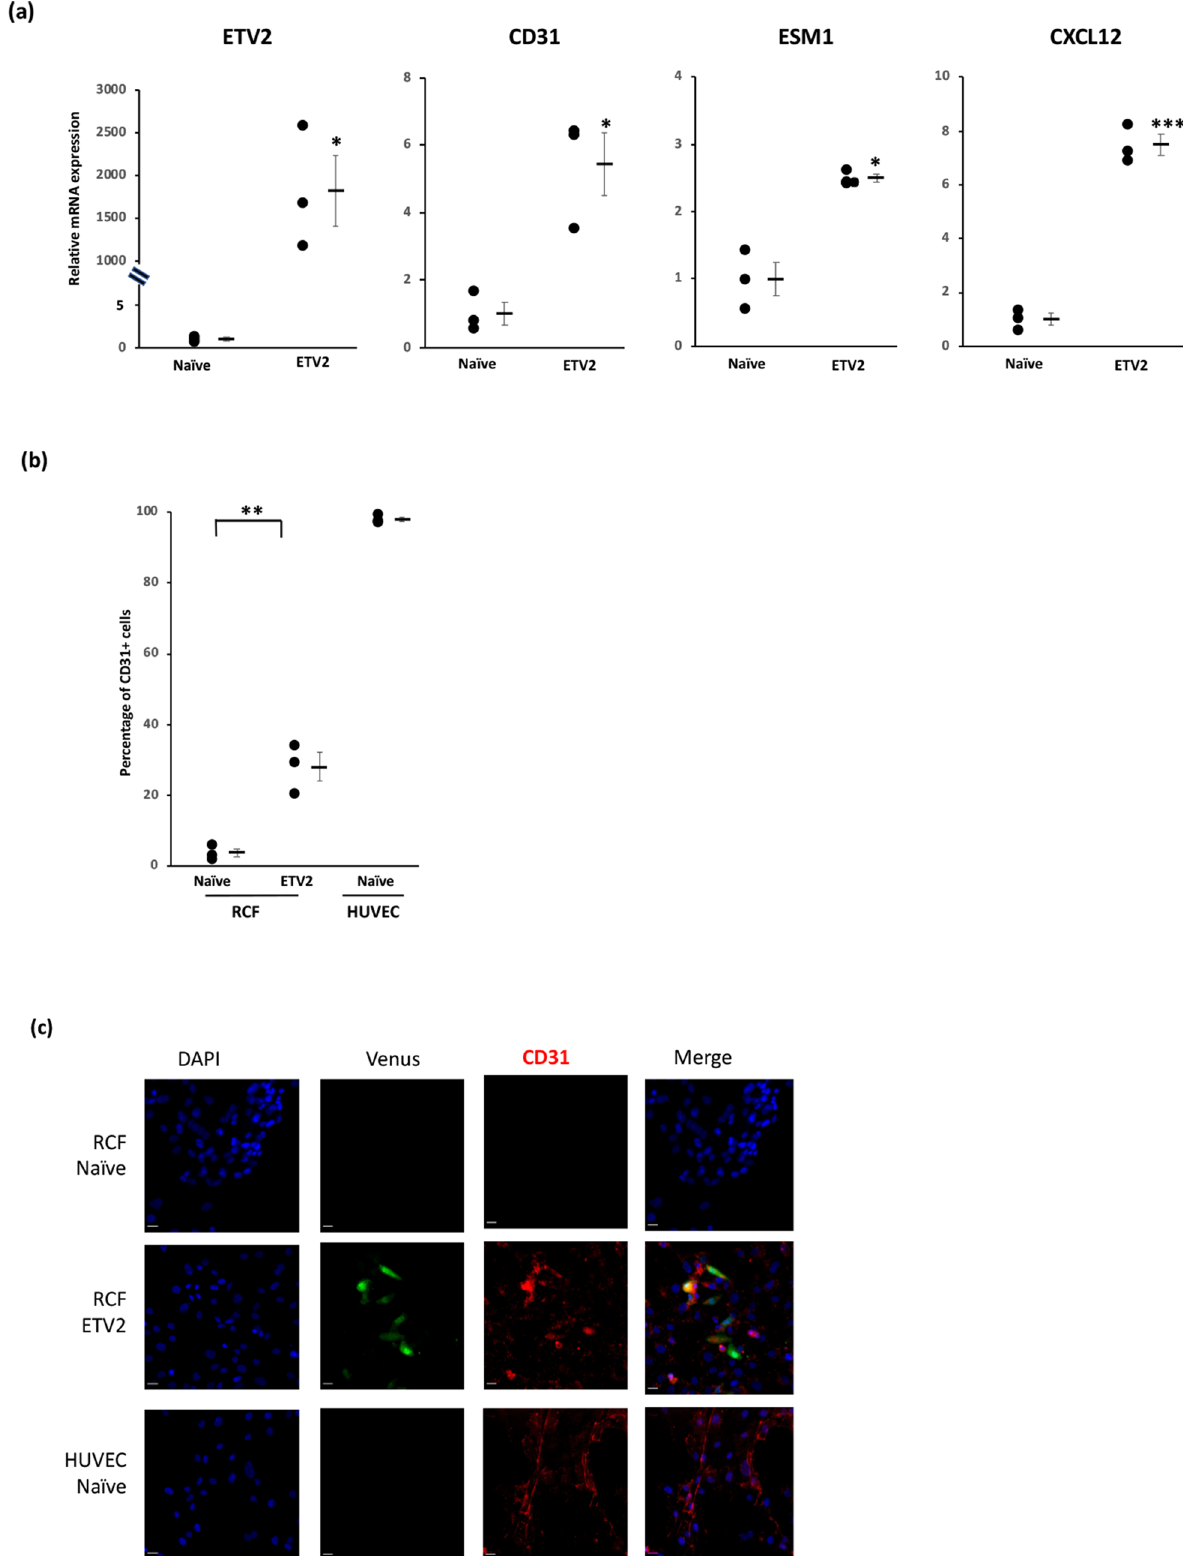
Figure 2. ETV2 induces expression of endothelial cell markers in cardiac fibroblasts. Rat cardiac fibroblasts were treated with doxycycline with or without administration of lentivirus encoding ETV2 and rtTA (n = 3). ( a ) qPCR analysis demonstrating upregulated expression of endothelial cell markers in ETV2-treated compared to naïve fibroblasts (*p < 0.05; ***p < 0.01). ( b ) Quantification of FACS data demonstrating an increased percentage of cells expressing endothelial cell marker CD31 in ETV2-treated compared to naïve fibroblasts (**p < 0.01). ( c ) Immunostaining demonstrating the presence of CD31 + cells in ETV2-treated compared to the absence of CD31 + expression by naïve fibroblasts. Scale bar: 200